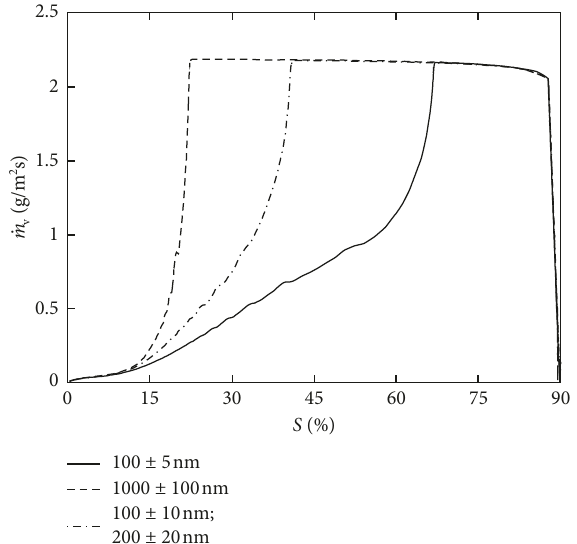
Figure 14: Drying curves for different pore-size distributions.